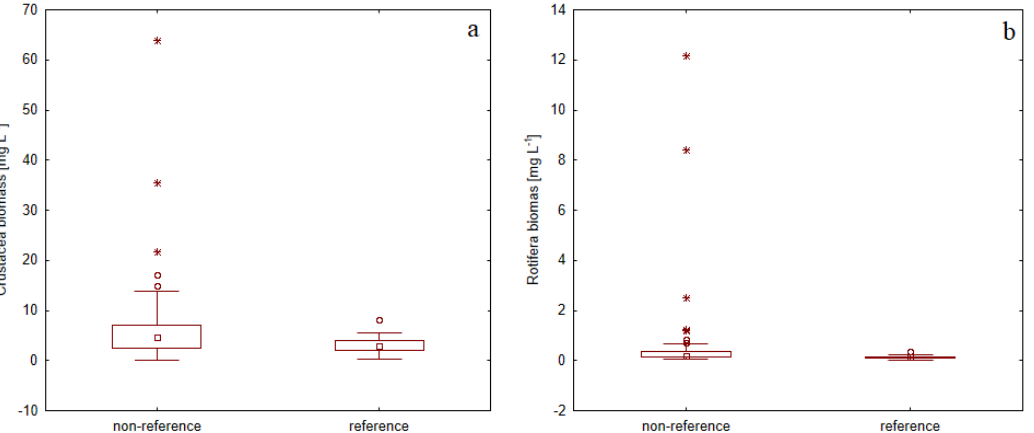
Figure 3. Biomass distribution of Crustacea ( a ) and Rotifera ( b ) in the reference (n = 17) and non- reference (n = 69) lakes. Boxplots present 25–75th percentiles with median (squares), whiskers are range, and circles are outliers and asterisks are extreme values.